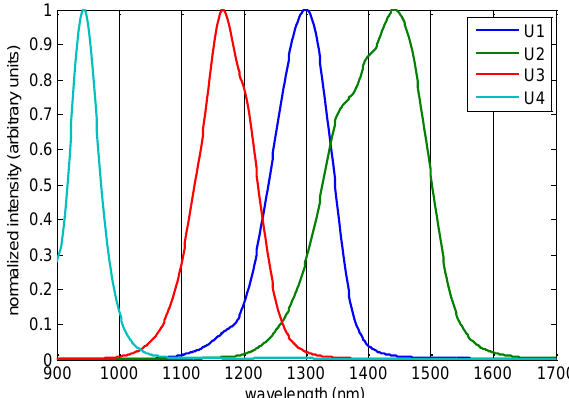
Figure 3. Normalized emission spectra of sensor light-emitting diodes (LEDs).